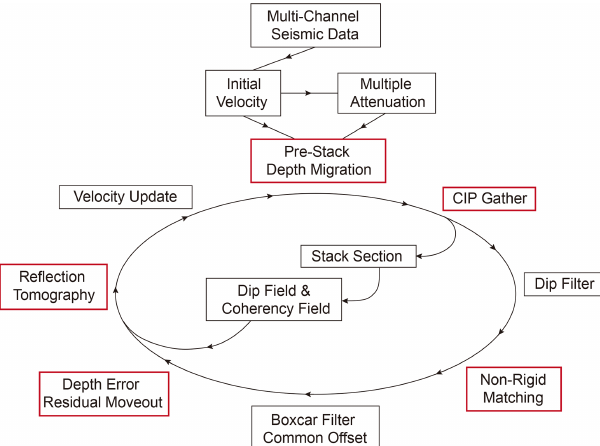
Figure 1. Processing scheme using non-rigid matching in reflec- tion tomography to update the velocity field during pre-stack depth migration of multi-channel seismic reflection data. The main pro- cessing steps are marked in